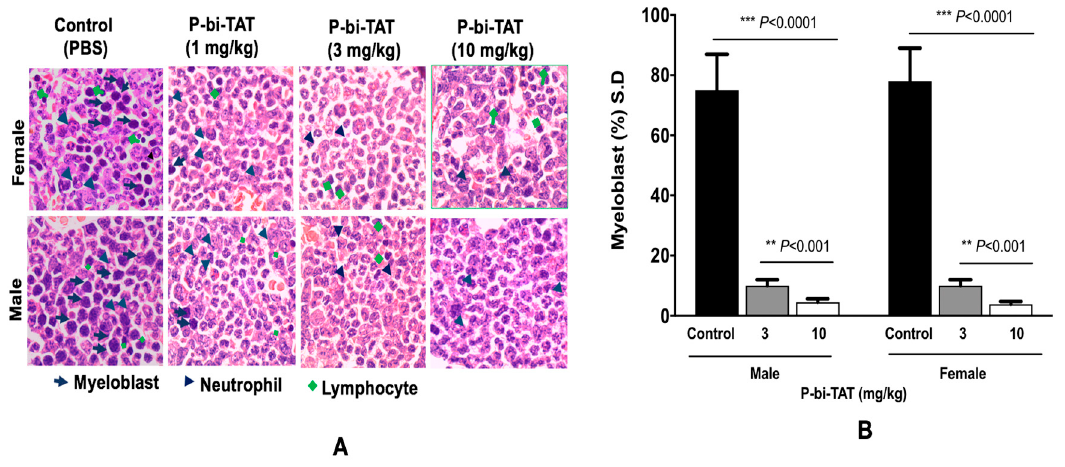
Figure 4. Myeloblast in bone marrow of NOD/SCID mice after 21 days of treatment with P-bi-TAT (3, and 10 mg/kg) ( A ) Blast cells decreased ~75–85% in comparison to the control group. ( B ) Percentage of myeloblast in bone marrow. Results are expressed as mean ± S.D, n = 4–5 mice/group, *** p < 0.001, ** p < 0.0001.